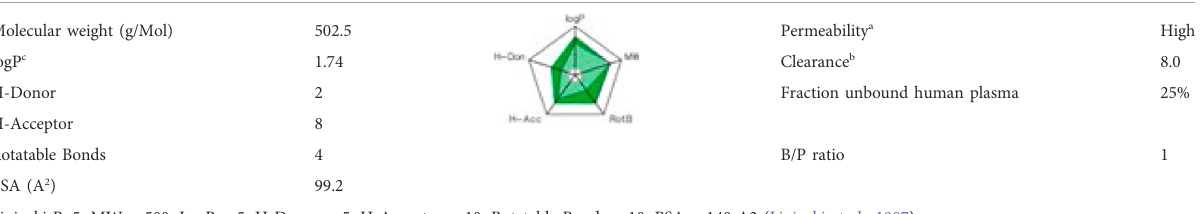
TABLE 2 Physicochemical and in vitro ADME properties.